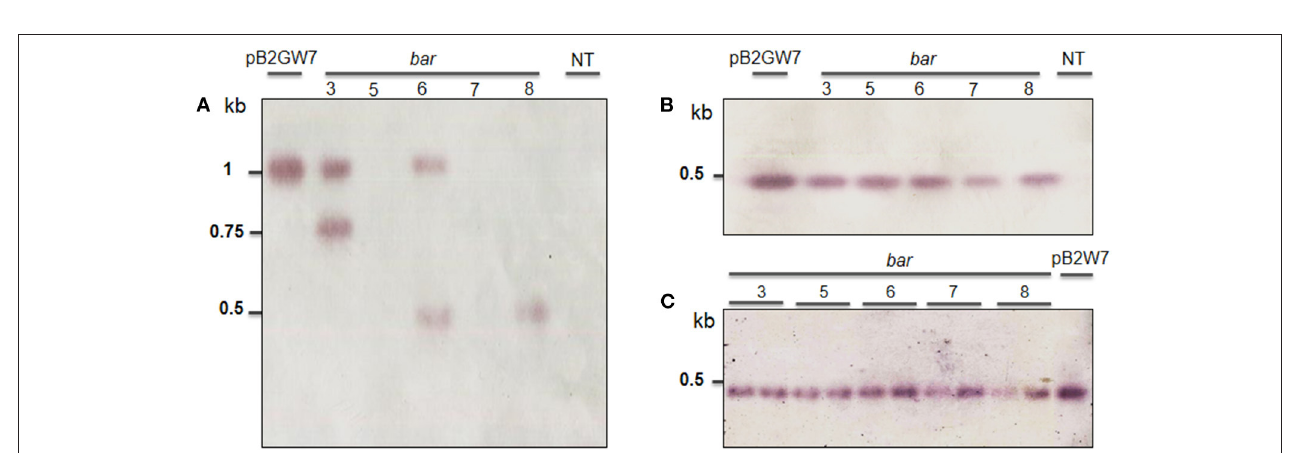
FIGURE 4 | Southern blot analysis of T1 to T3 transgenic plants obtained from Agrobacterium -mediated transformation of VX93 cultivar. The DNA soybean transgenic plant was cut by Sac I enzyme. The process used the probe- bar gene expression in NBT-BCIP. The figures (A, B) indicated T1 and T2 generation (left to right), lane 1 is pB2GW7 vector, lane 2 to 6 (five plants), lane 7 is a non-transgenic plant (NT). (C) T3 generation (left to right), lanes 1–10 (ten plants), and lane 11 is pB2GW7 vector. Plants were chosen randomly for southern blot